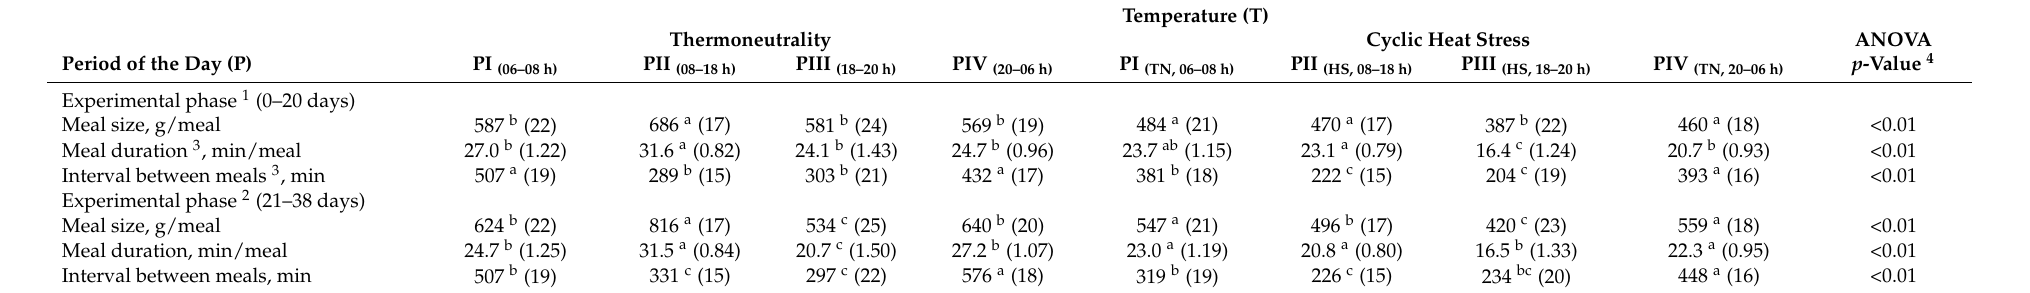
Table 3. Feeding behavior of finishing pigs exposed to thermoneutrality conditions or cyclic heat stress conditions, according to the period of the day in each experimental phase 1,2